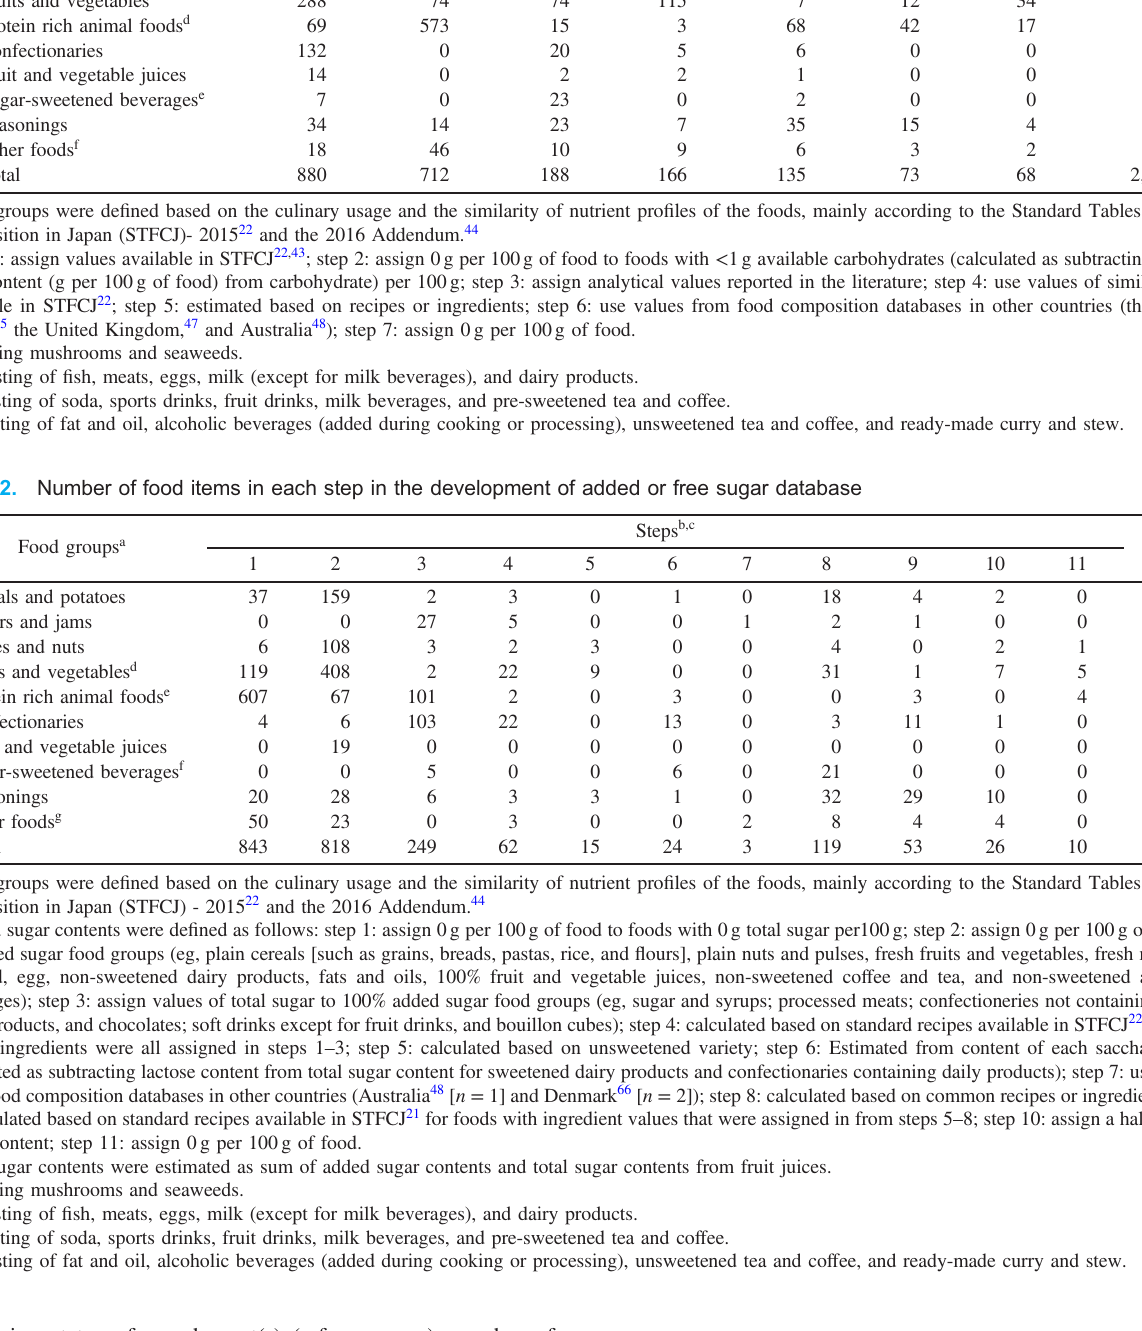
Table 1. Number of food items in each step in the development of a total sugar database Food groups a Cereals and potatoes